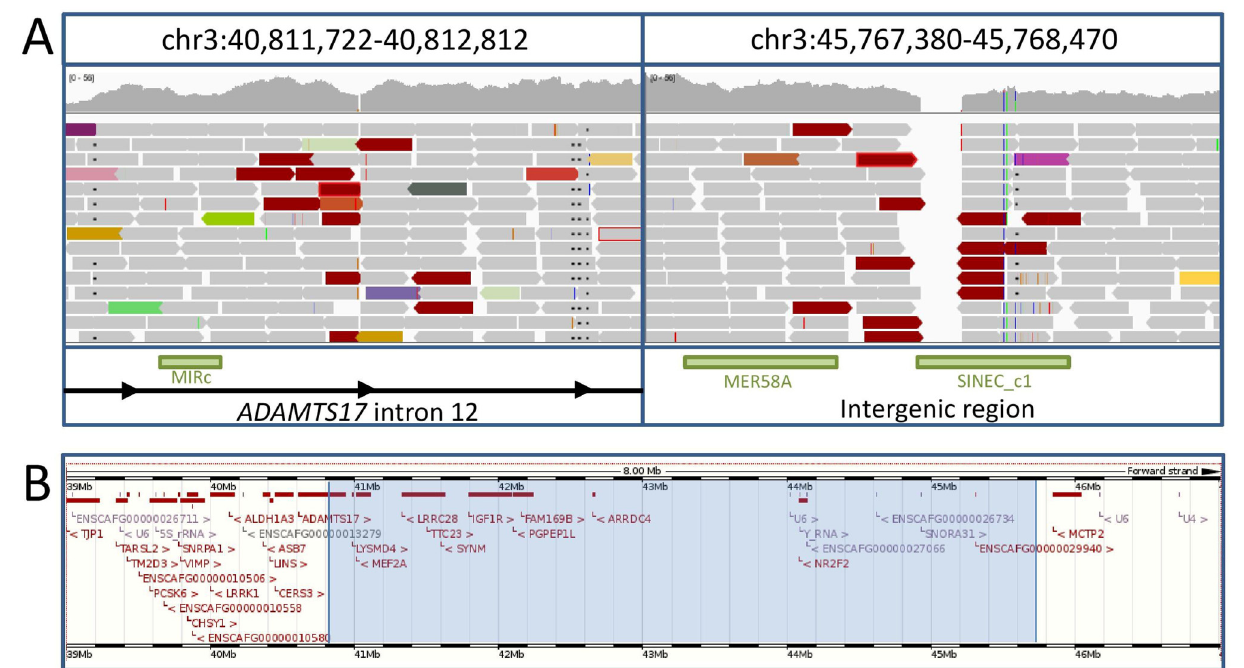
Fig 4. The POAG associated inversion. (A) Reads aligning across the inversion breakpoints. Red reads indicate a greater than expected insert size. Read mates for red reads align in the same direction, indicative of an inversion. There were five deleted bases at the 5 ’ inversion breakpoint and 78 deleted bases at the 3 ’ deletion breakpoint. Green boxes indicate repeat elements. (B) Overview of the genomic region covered by the inversion. The inverted region is highlighted in blue. Genotyping of the inversion was carried out to confirm the association with POAG. A total of 225 PBGVs were genotyped, including 28 POAG cases, of which 27 were homozygous for the inversion. Results are summarised in Table 1.